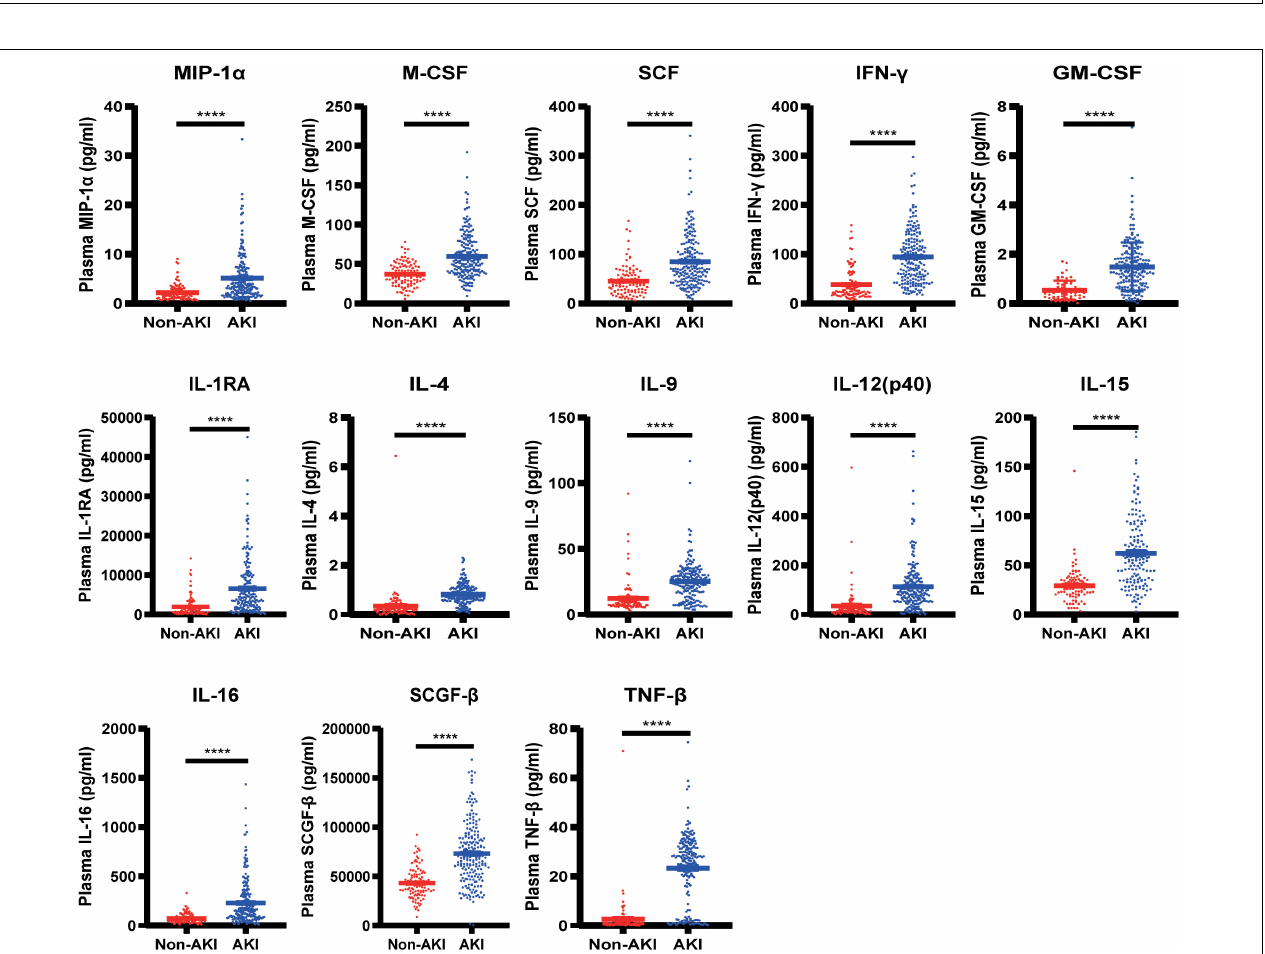
FIGURE 4 | The most significantly changed cytokines between the AKI and non-AKI groups. **** p < 0.00001.